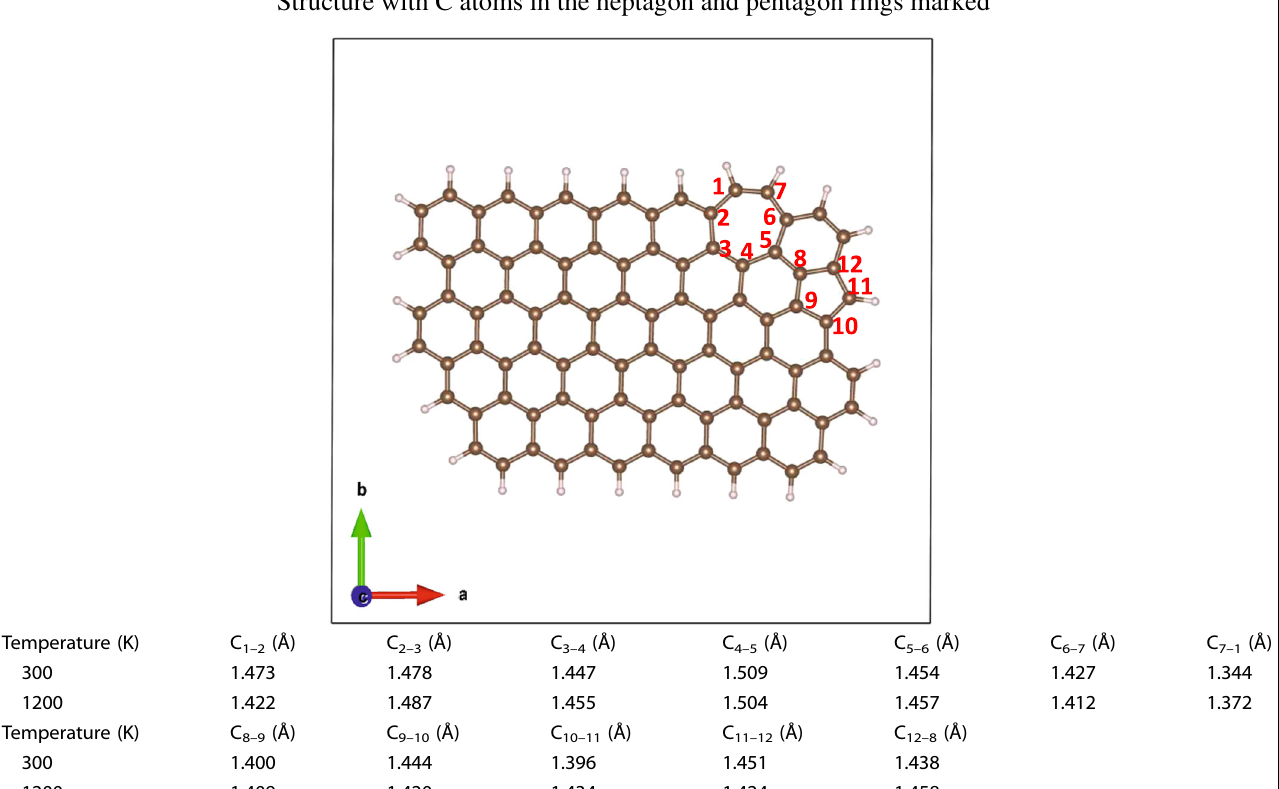
Table 1. Distances between C atoms in heptagonal and pentagonal rings at 300 and 1200 K temperatures after 2 ps. Structure with C atoms in the heptagon and pentagon rings